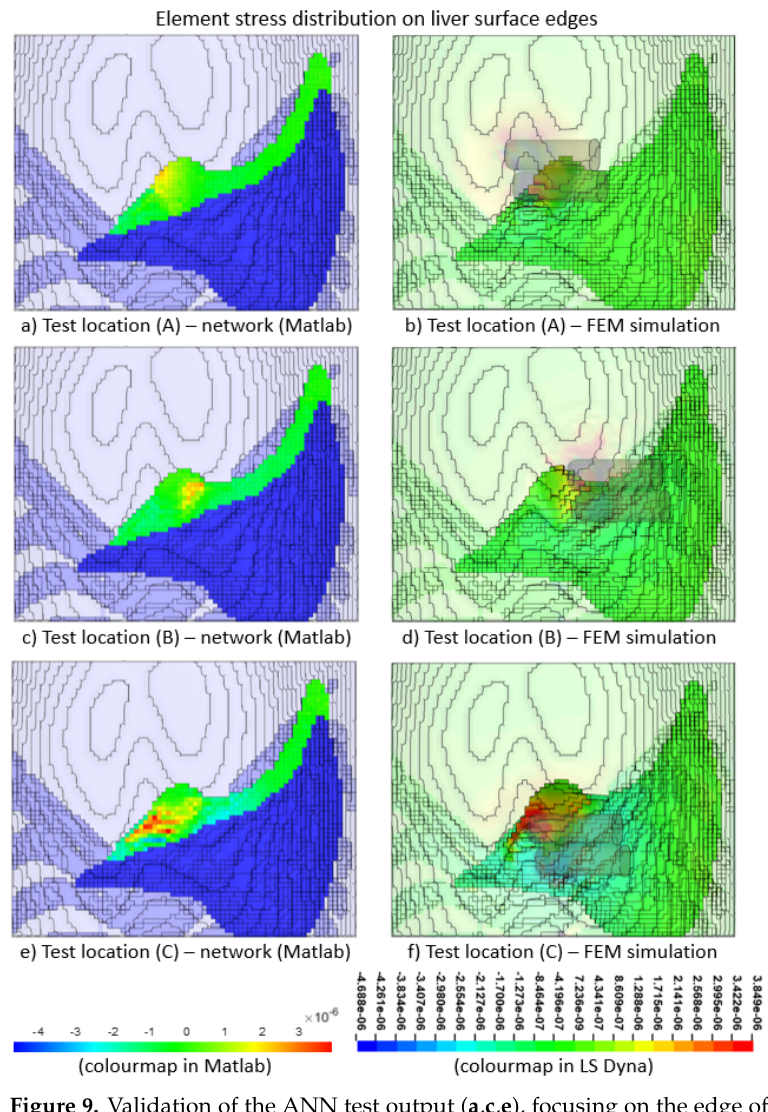
Figure 9. Validation of the ANN test output ( a , c , e ), focusing on the edge of the liver against FEM simulations ( b , d , f ) for cases A, B, and C, respectively, according to test locations shown in Figure 4a. (Note: The colour map illustrating the maximum principal stress ( GPa) in the ANN is not exactly the same as that in LS-Dyna; hence, there is a difference between the colour distributions in the images